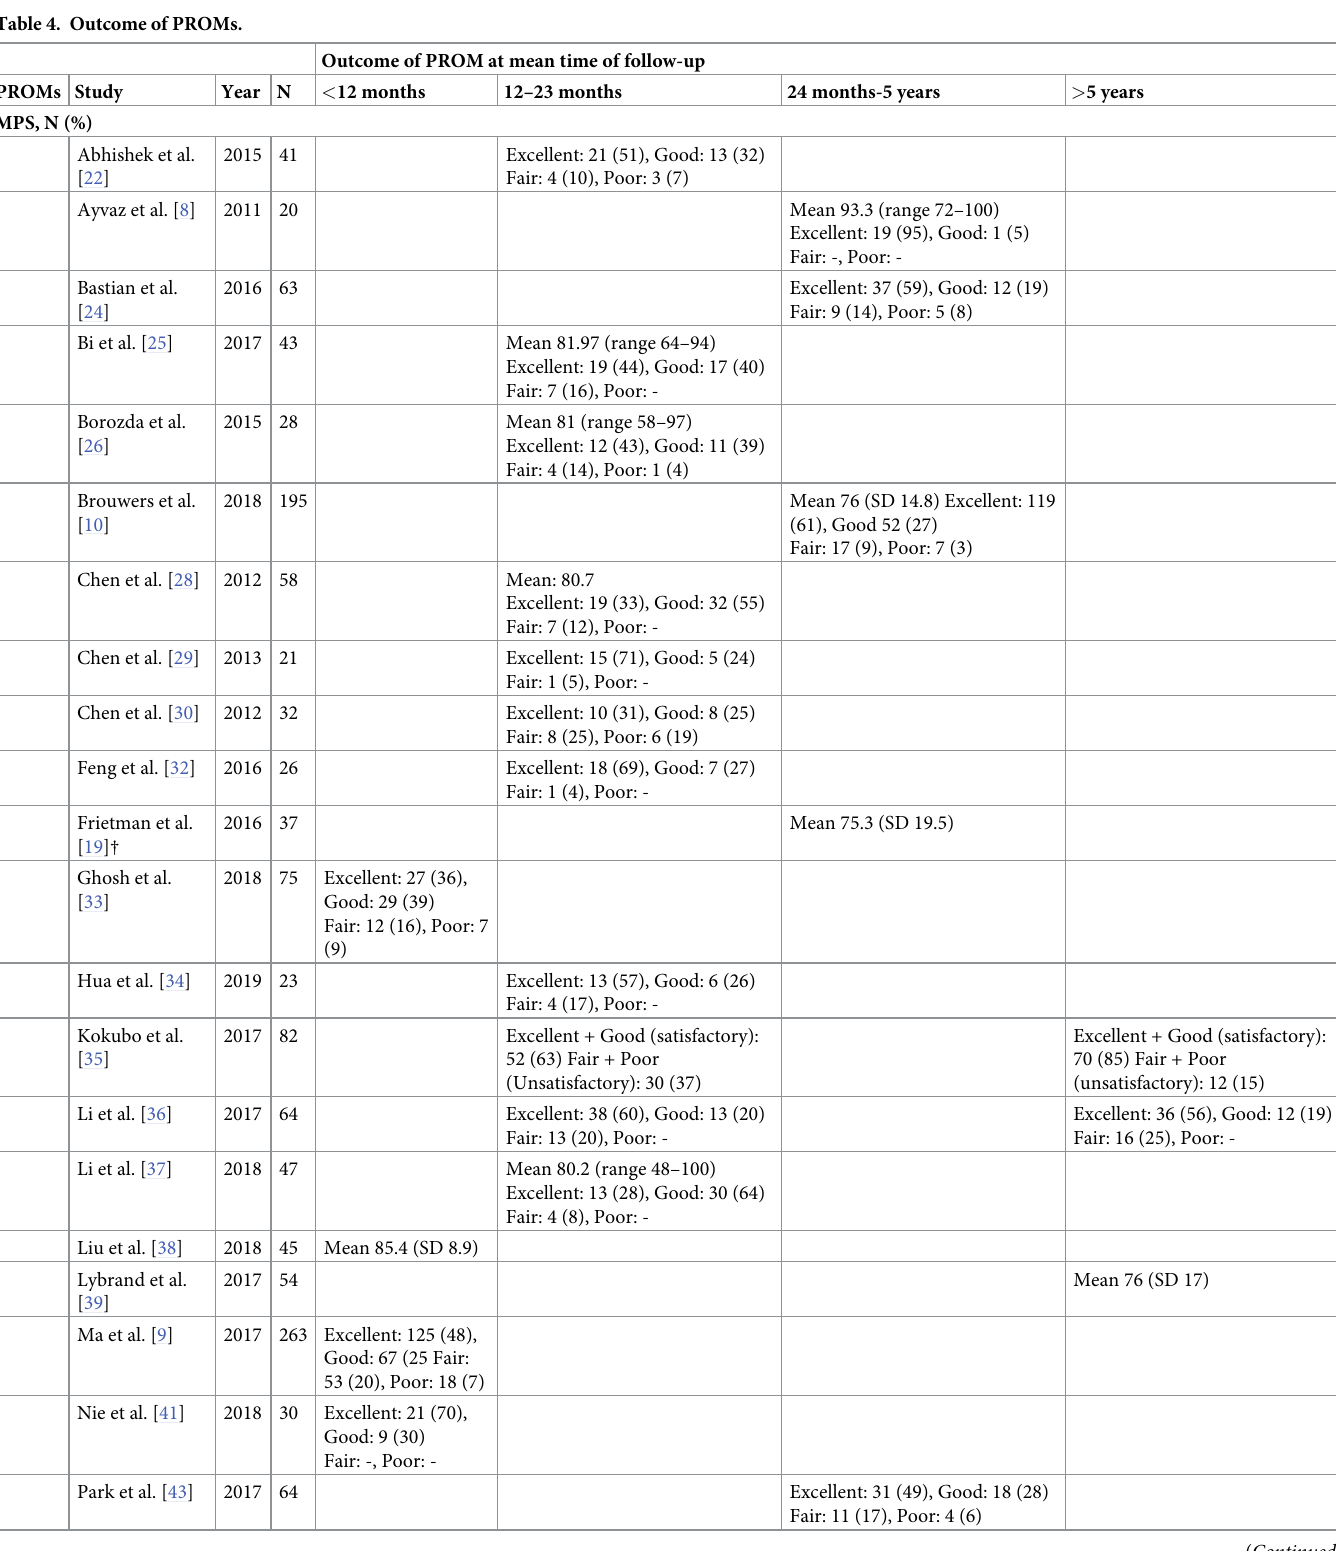
Table 4. Outcome of